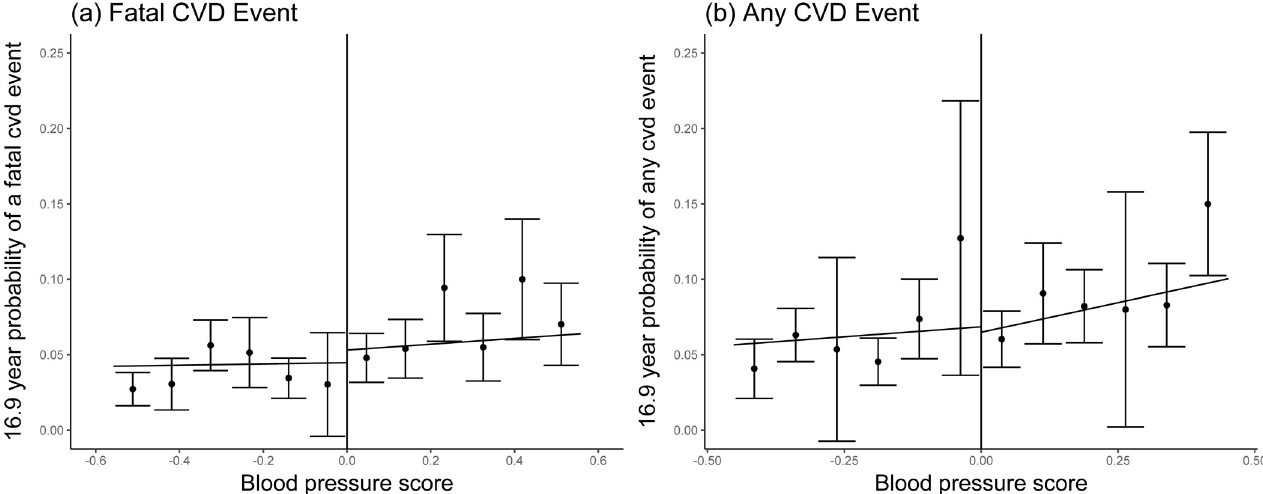
Fig 2. Graphical representation of the effect at the threshold (with 95% CI). (a and b) Graphical representation of the effect at the threshold, with linear associations between the assignment variable (BPS) and the respective outcomes for individuals just below and just above the intervention cutoff (BPS = 0) for ( a ) 16.9 years fatal CVD event and ( b ) 16.9 years any CVD event. The ‘jump’ of the regression line at the threshold represents the intention to treat effect at the threshold. BPS, blood pressure score; CI, confidence interval; CVD, cardiovascular